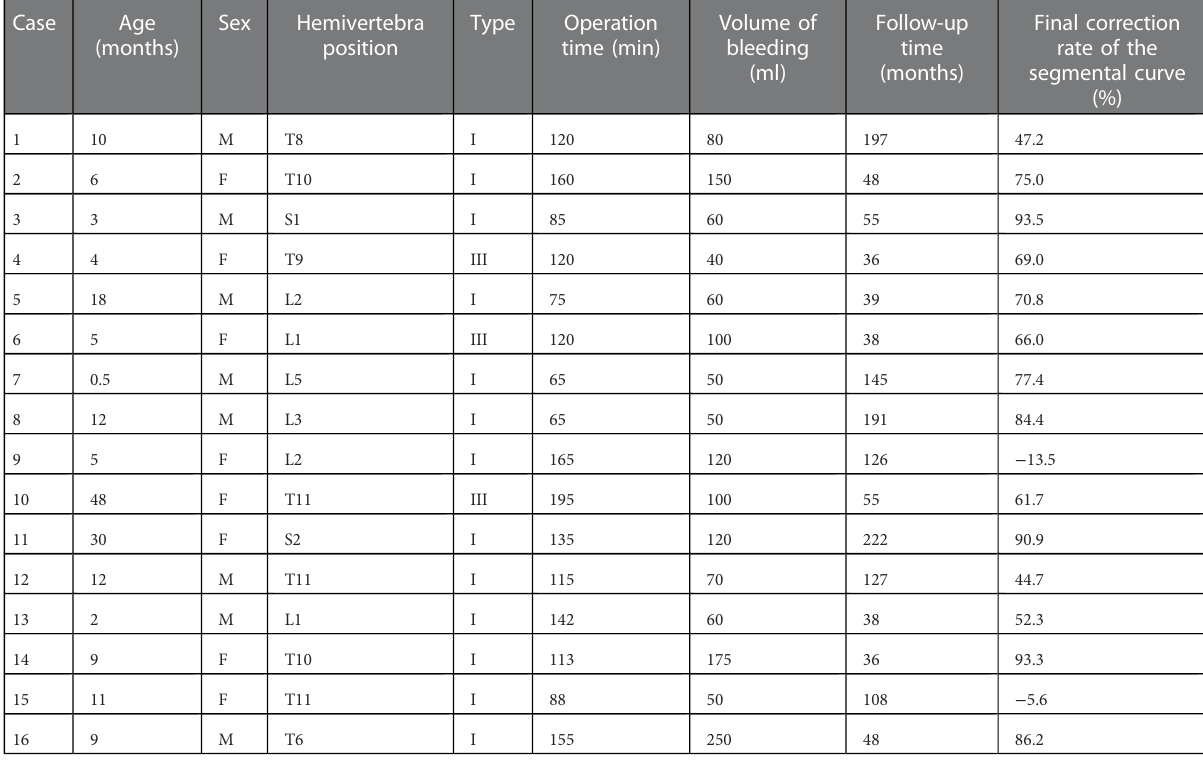
TABLE 1 Clinical data of the included